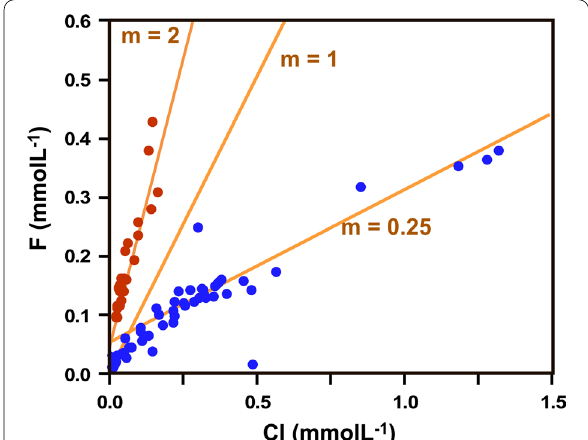
Fig. 8 Chloride vs. fluoride concentration in mmol L − 1 . Samples with F > Cl in red, samples with F < Cl as blue dots. All samples from the Gotthad Massif (GM). m slope of reference =